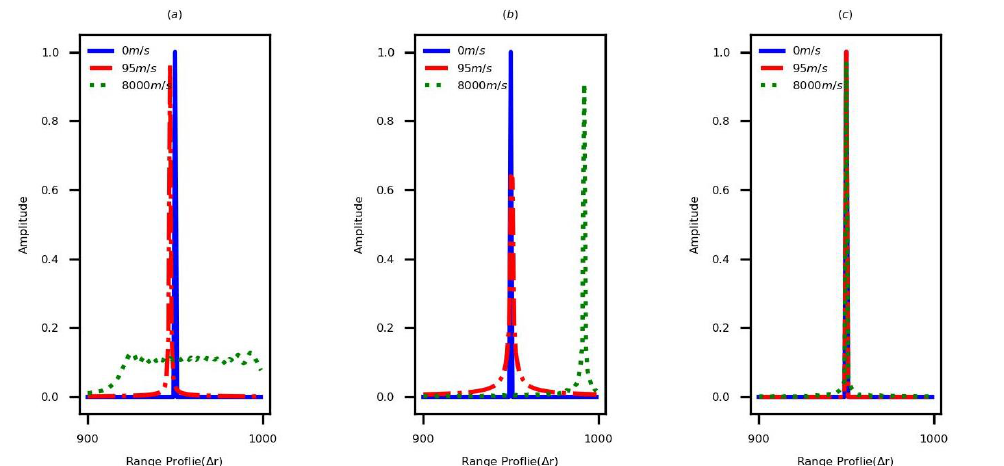
Figure 4. The HRRPs of the single-scattering-point target generated by the normal SF and the sequentially transmitted and cross-transmitted DSF waveforms in different velocities, based on the parameter set 2. ( a ) Normal SF. ( b ) Sequentially transmitted DSF waveform. ( c ) Cross-transmitted DSF waveform.